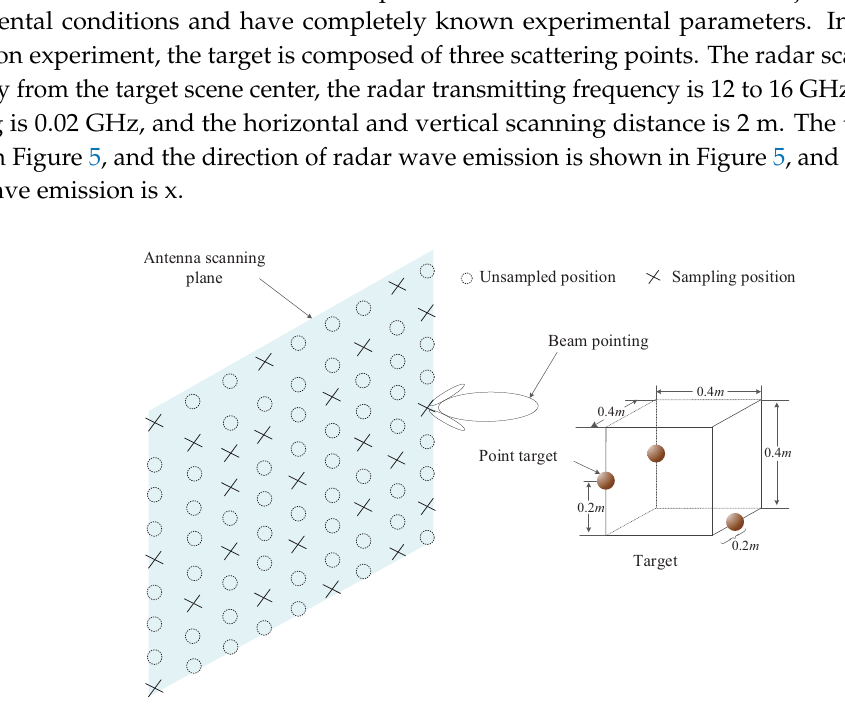
Figure 5. Computer simulation of the target